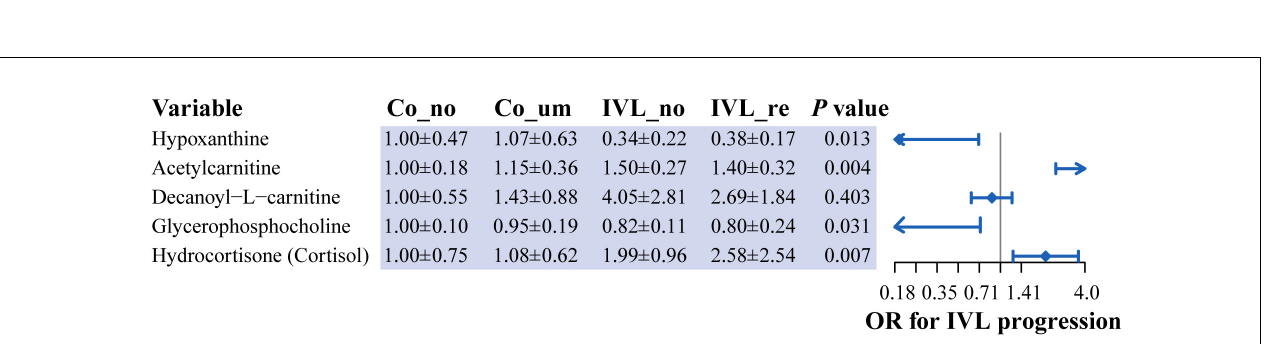
FIGURE 5 | Identification of hub metabolites based on generalized linear regression model. Forest plot displayed the odds ratio of five metabolites in the progression of IVL. P -value was calculated by generalized linear regression model, adjusted for the relative content of these metabolites.